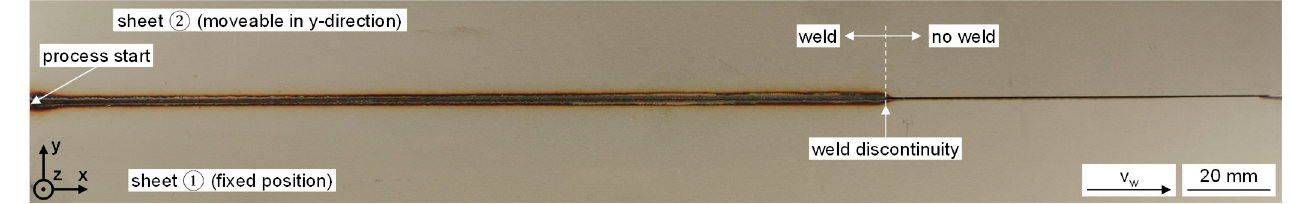
Figure 7. Top view of an uncontrolled weld with unhindered gap formation (v w = 1 m/min, P L = 0.4 kW).